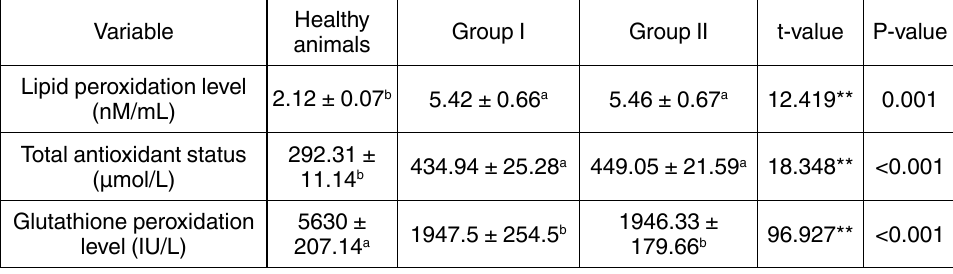
table 1. Comparison of oxidative stress parameters among group I, II and healthy animals